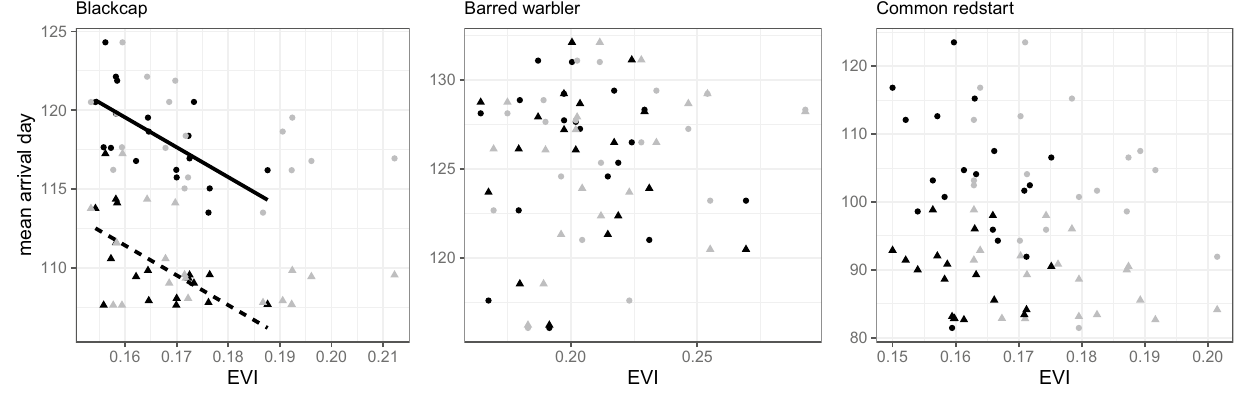
Figure 5. The relationship between mean arrival day and average Enhanced Vegetation Index (EVI). EVI is calculated at the species-specific non-breeding grounds during the years 2000–2017 in the months prior to migration departure: February (black symbols) and March (grey symbols) in the three study species. Triangles denote males and circles denote females. Predicted lines for males (dashed line) and females (solid line) are drawn from a general linear mixed effect model (GLMM) with year as both fixed and random effect for significant slopes in the blackcap ( P <